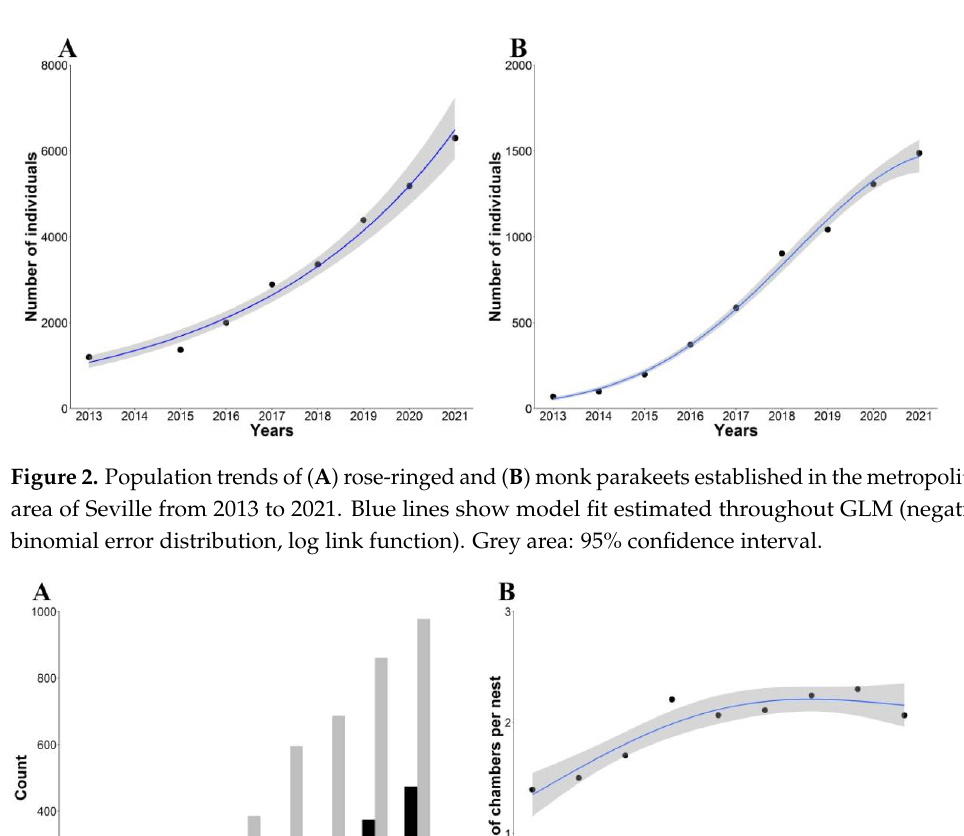
Figure 3. ( A ) Number of nests (black bars) and total number of active chambers (grey bars) of monk parakeets censused in the metropolitan area of Seville from 2013 to 2021, and ( B ) mean number of active chambers per nest. The blue line shows the fitted generalized additive model (grey area: 95% confidence interval).